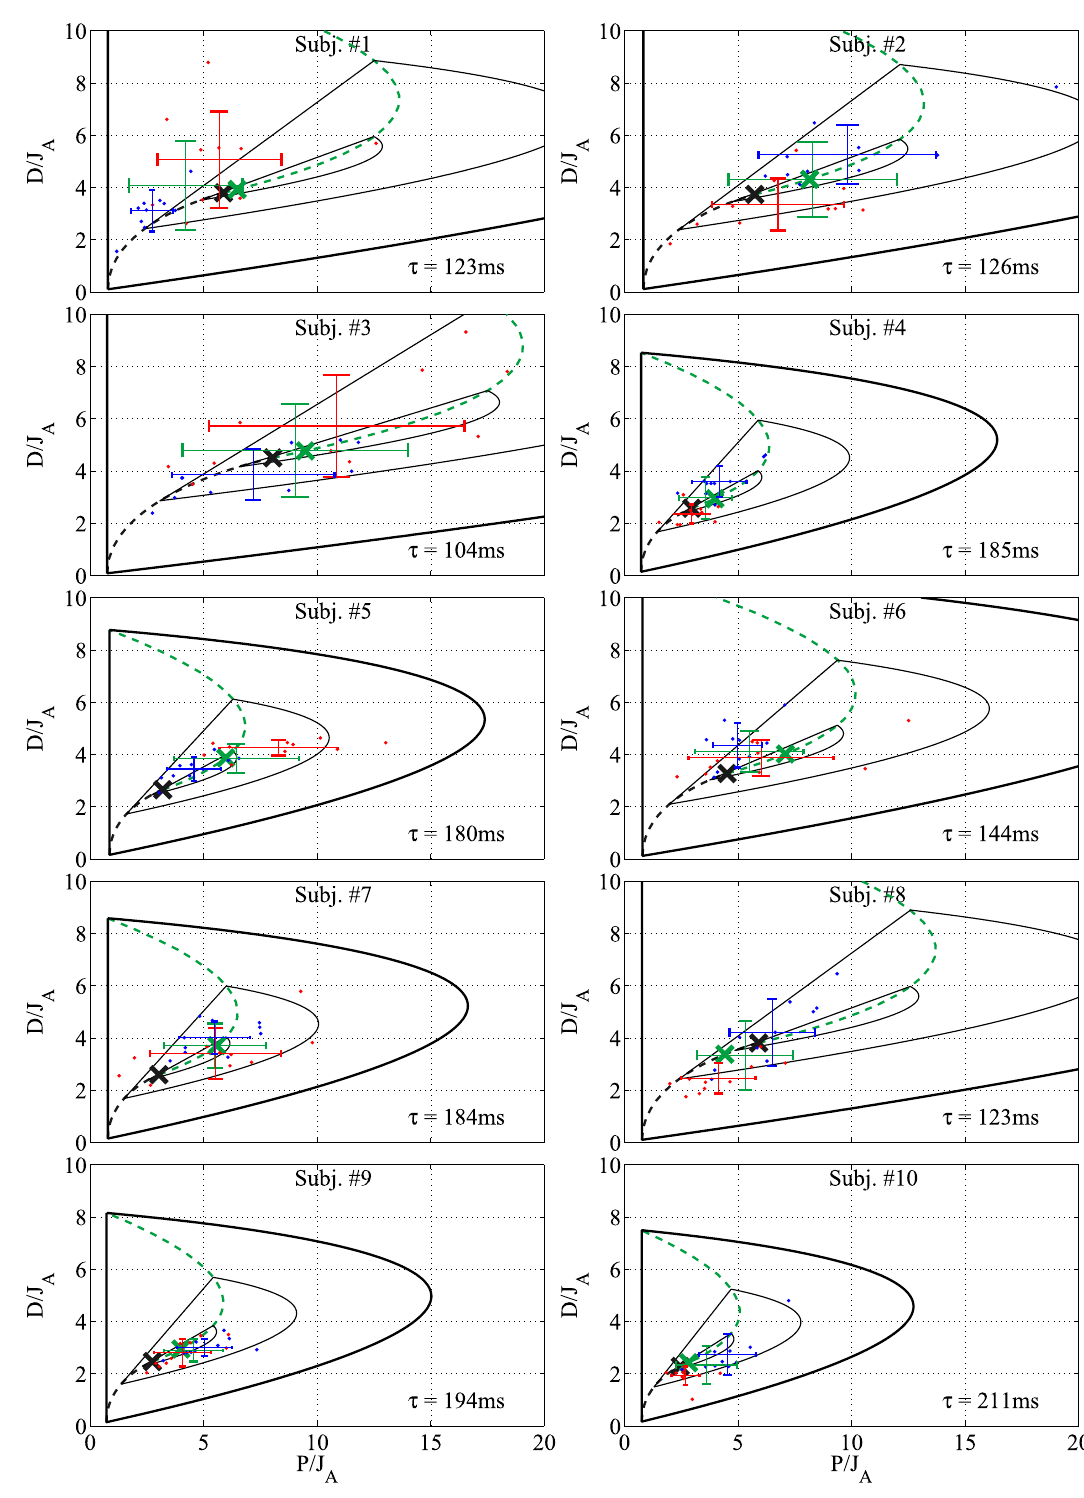
Figure 3. Stability diagrams for the 10 individual subjects and the fitted control parameters. Stability boundary ( γ 1 = 0 ) is indicated by thick black line, while thin black lines denote contour curves of γ 1 = 1 3 γ ∗ and γ 1 = 2 3 γ ∗ . The node-spiral separation line is shown by black-green dashed line, and the parameter point associated with the fastest decay ( γ 1 = γ ∗ ) by black × marker. Red markers indicate PA trials, blue markers indicate AP trials. Means and standard deviations for the PA and the AP trials are shown by red and blue lines, respectively. Green lines indicate the mean and standard deviation for all the 20 trials. The point on the node- spiral separation line that is closest to the mean of the 20 trials is indicated by green